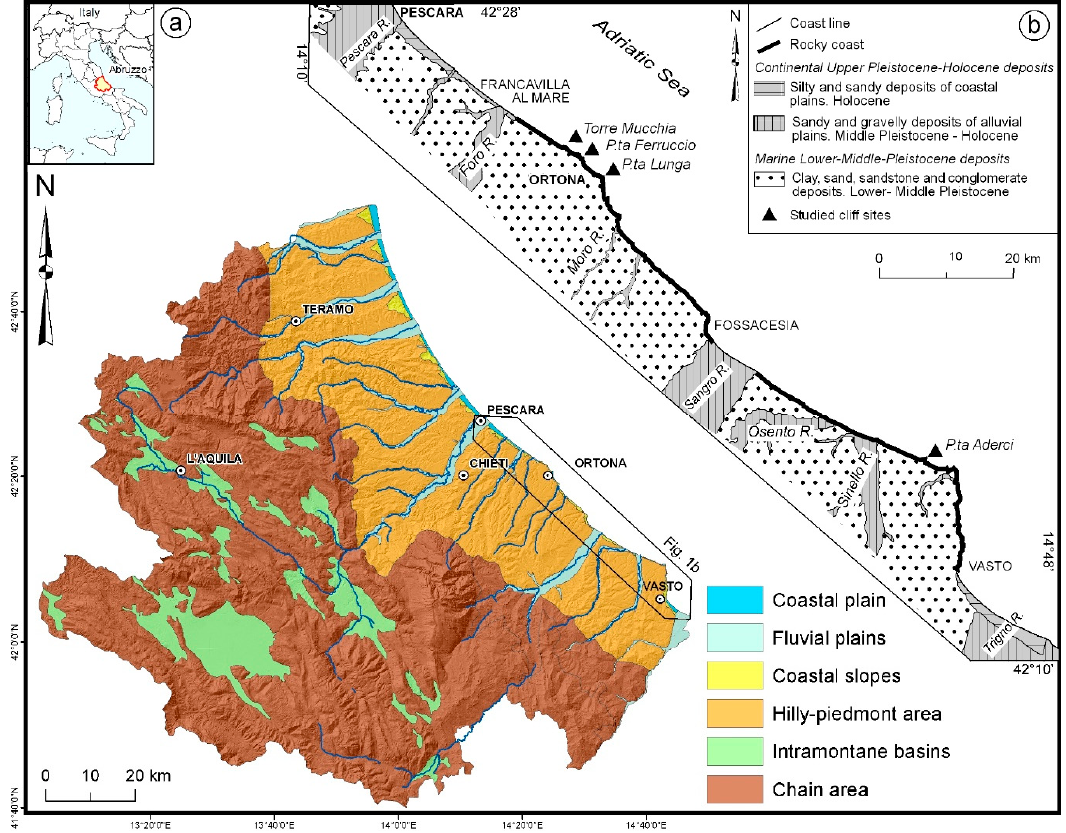
Figure 1. ( a ) The main physiographic domains of the Abruzzo region (according to the morphotectonic landscape classification, D’Alessandro et al. 2003 [29]). The black polygon indicates the study area. ( b ) The lithological scheme of the study area and location of the cliff sites (modified from Miccadei et al. 2019 [7]).